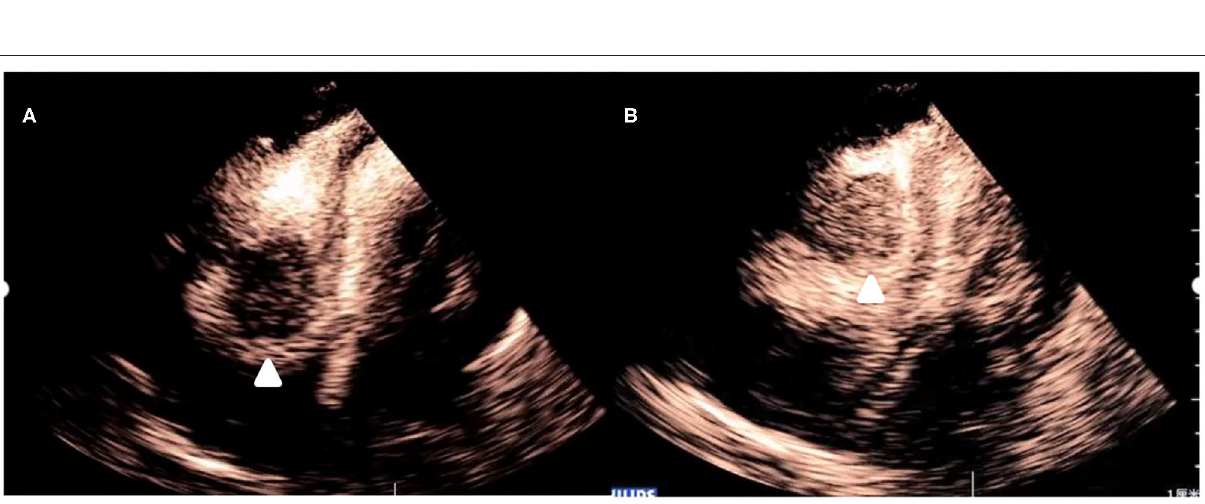
Frontiers in Cardiovascular Medicine |